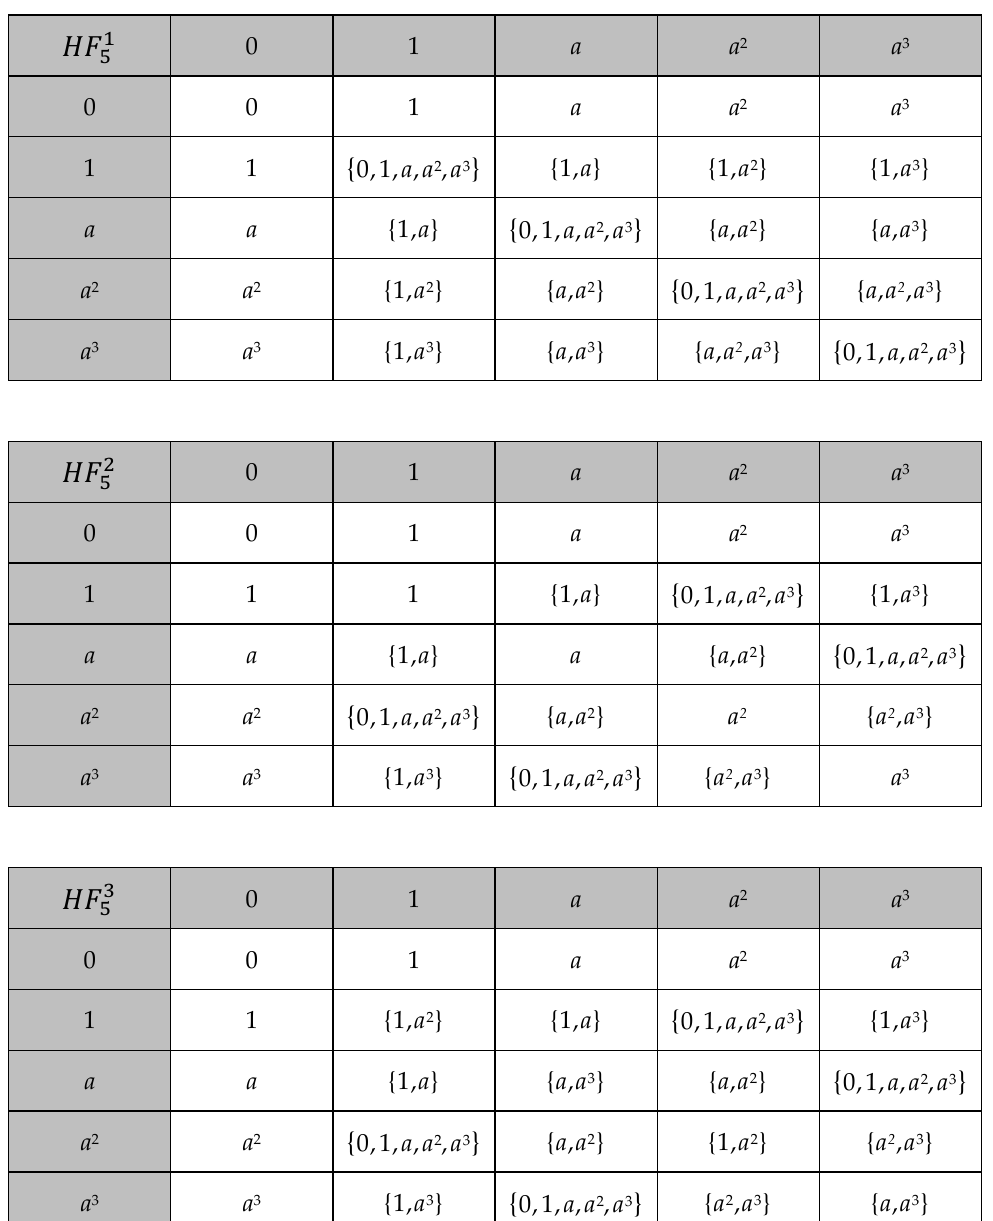
Table 25. The Cayley tables of the additive canonical hypergroup of the three non-classified hyperfields with multiplicative group C 4 .